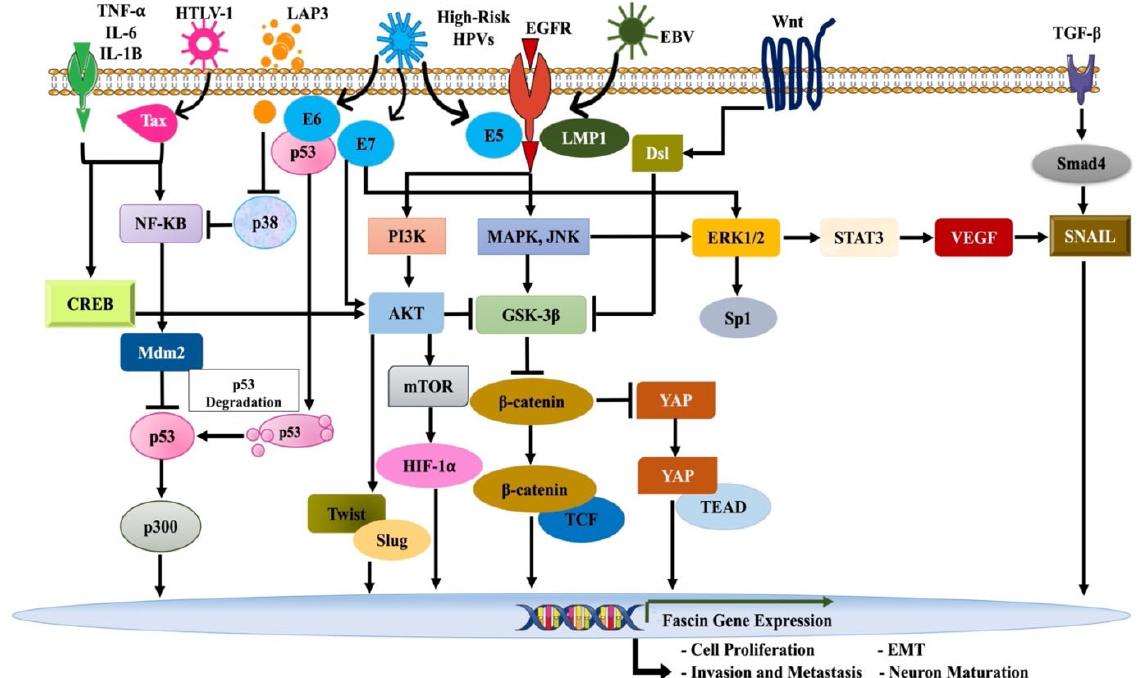
Figure 1. Mechanisms of FSCN1 deregulation. Several factors, including EGFR, TGF- β , and interleukins, in addition to oncoviruses, trigger key pathways including CREB, ERK1/2, JNK, STAT3, PI3K, MAPK, and NF- κ B to deregulate FSCN1 expression and stimulate underlying mechanisms for cancer progression.